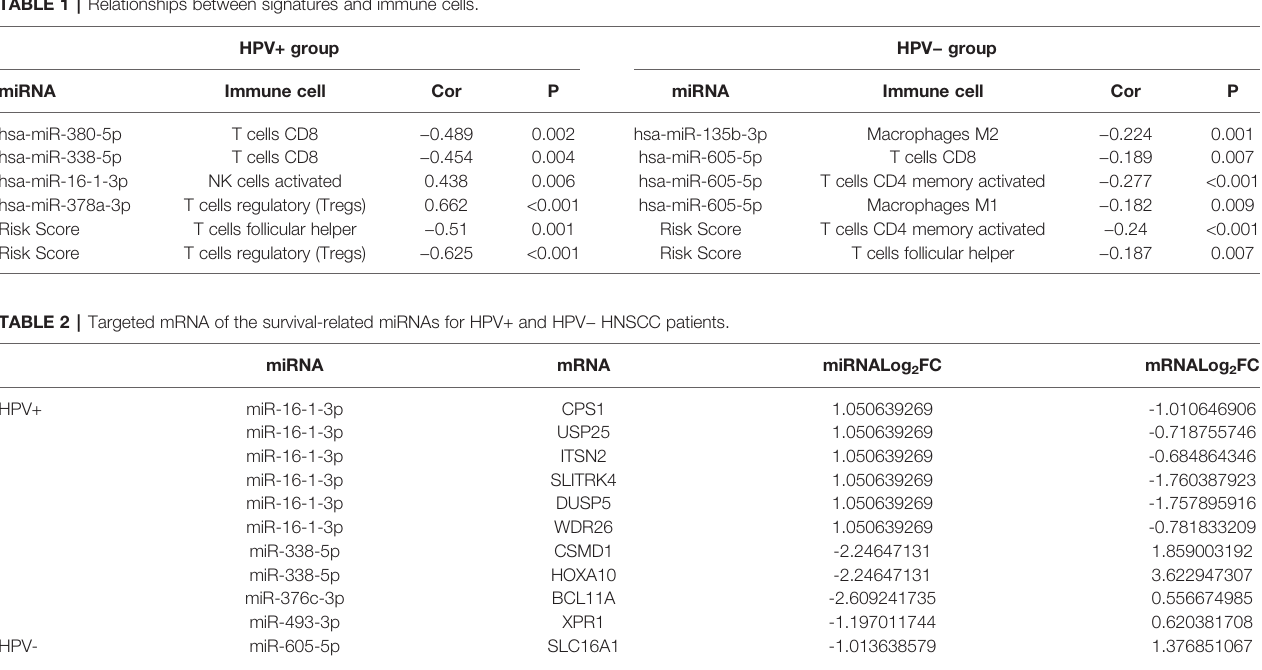
TABLE 1 | Relationships between signatures and immune cells.